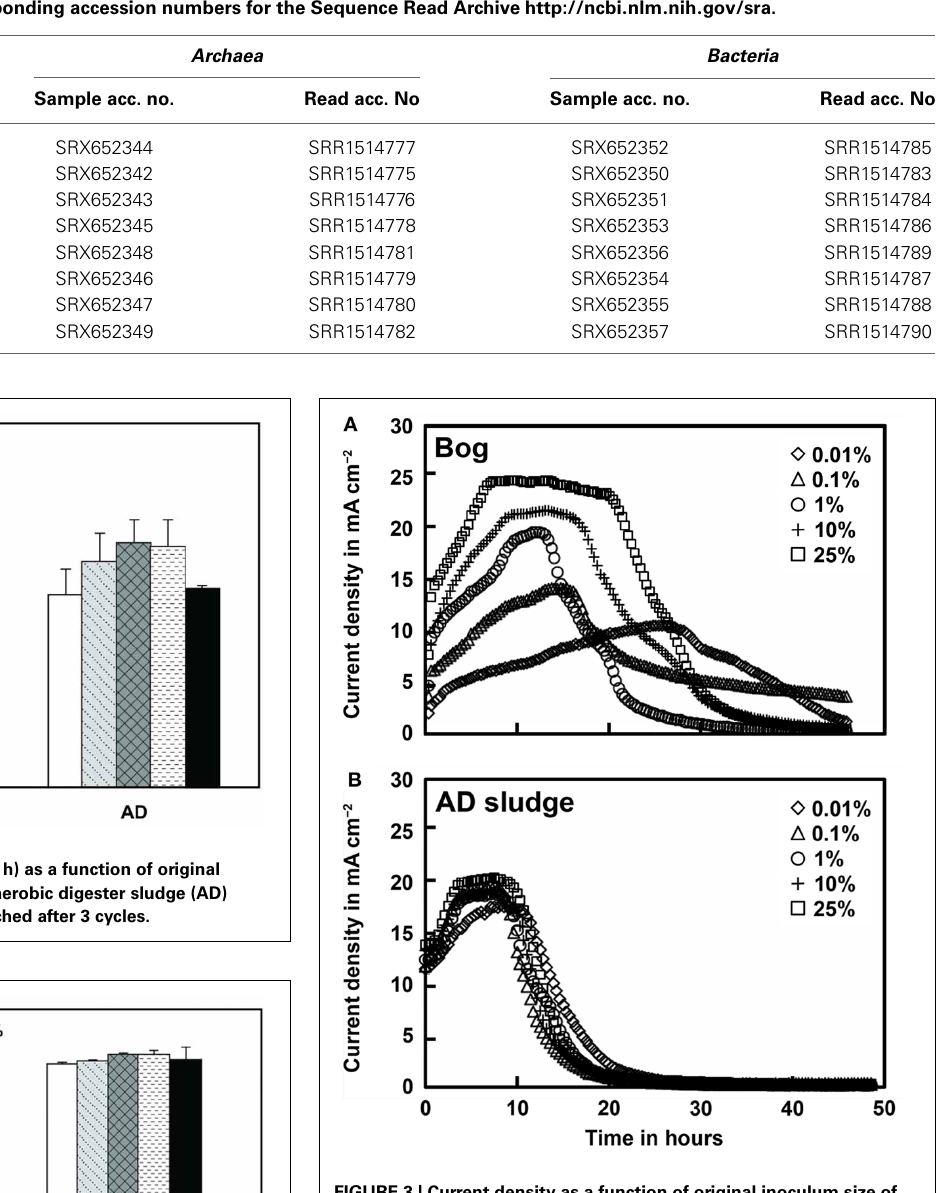
FIGURE 3 | Current density as a function of original inoculum size of bog (A) and anaerobic digester sludge (B) inoculated reactors after full acclimation of 3